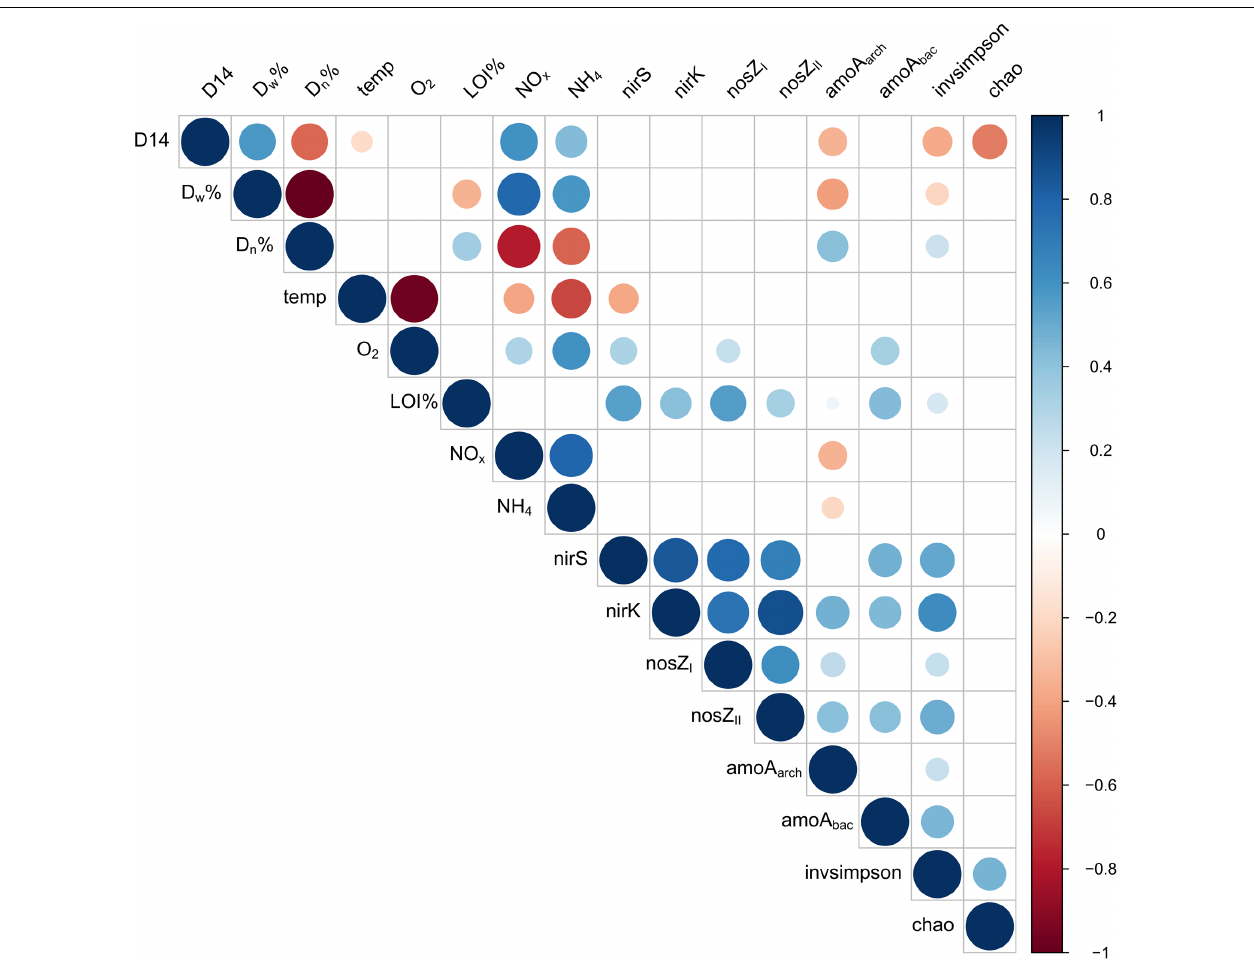
FIGURE 3 | Correlation plot describing interactions between total denitrification (D14), the proportion of denitrification of the NO 3 − in the water above the sediment (Dw%), the proportion of coupled nitrification-denitrification (Dn%), temperature, oxygen concentration, proportion of organic matter in the sediment (LOI%), nitrate concentration (NO x − ), ammonium concentration (NH 4 + ), abundances of functional genes ( nirS , nirK , nosZ I , nosZ II , amoA arch , amoA bac ) and bacterial diversity (Inverse Simpson index) and richness (chao richness estimator) on Keuruu study